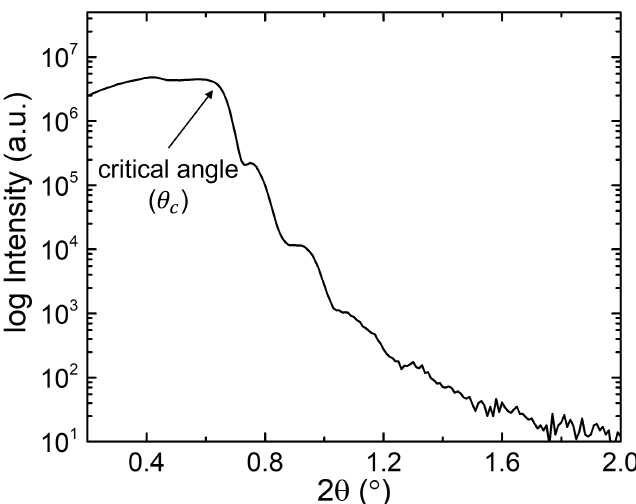
Figure 2. X-ray reflectometry (XRR) spectrum that allowed thickness evaluation of the ultra-thin ZnO film as ∼ 55